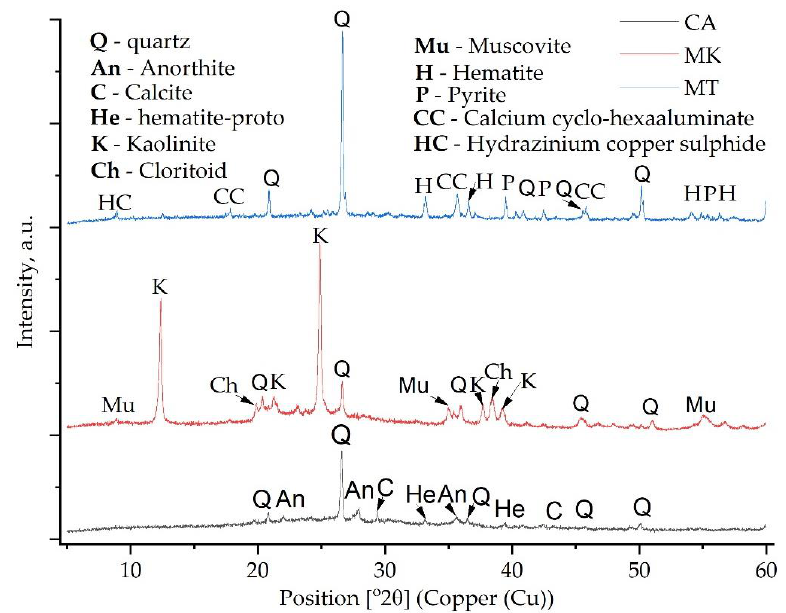
Figure 3. The XRD pattern of the raw materials used in this study.